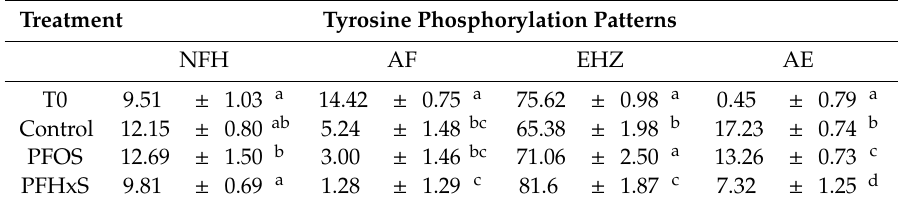
Table 2. Effect of PCFs in tyrosine residues phosphorylation patterns in boar sperm capacitation. Treatment